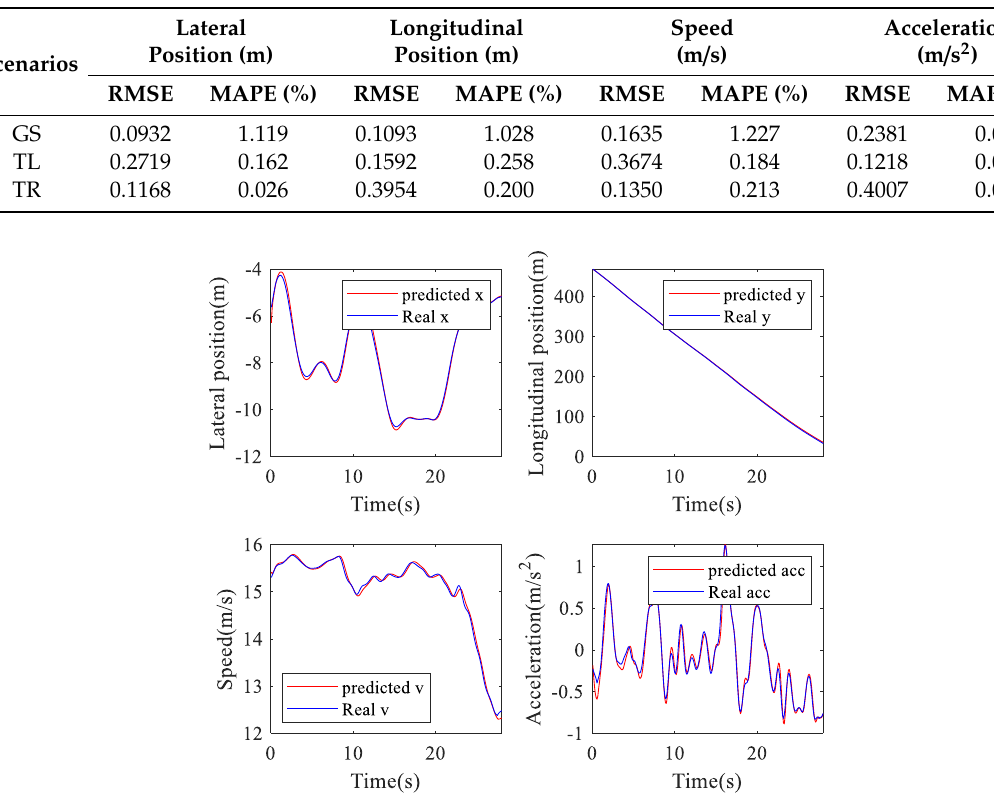
Figure 11. Going straight prediction.